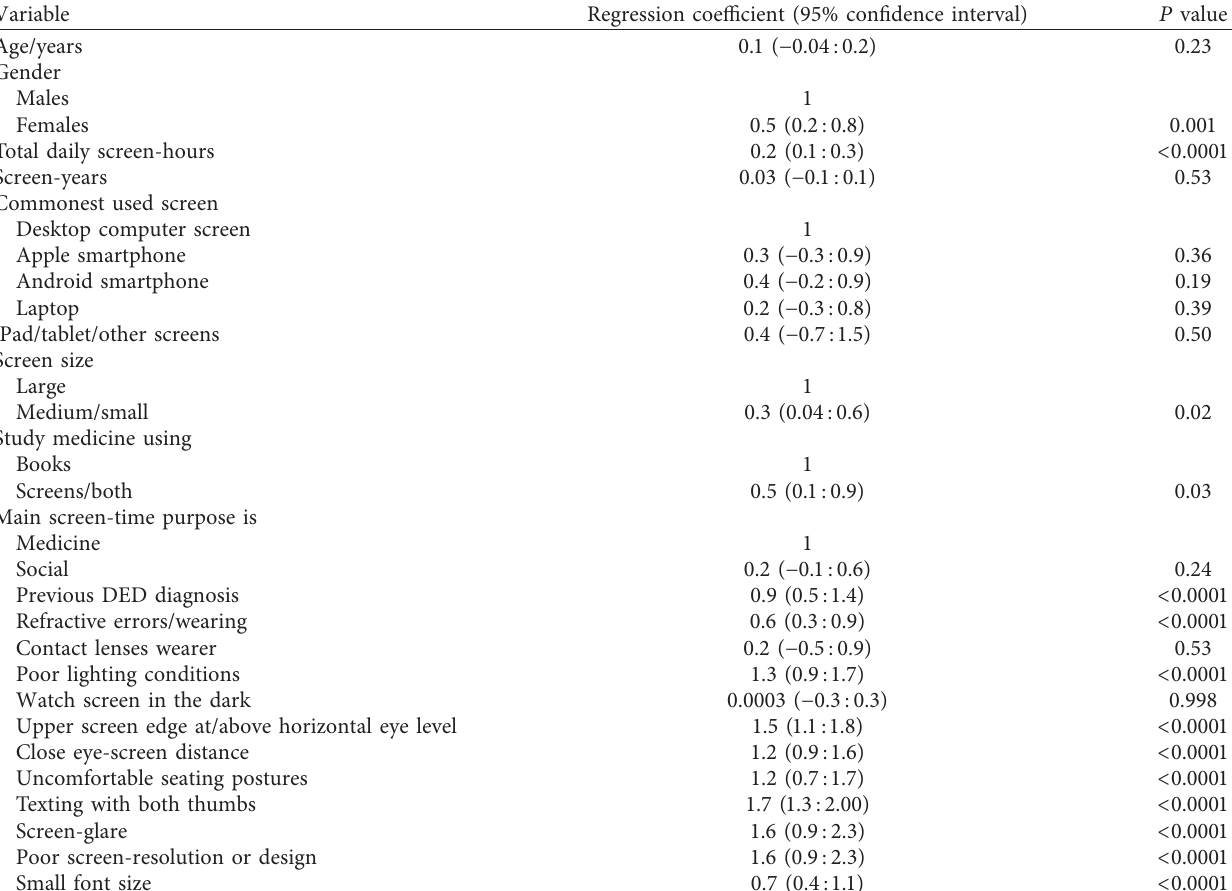
Table 7: Multivariate linear regression analysis of factors affecting the total number of symptoms.